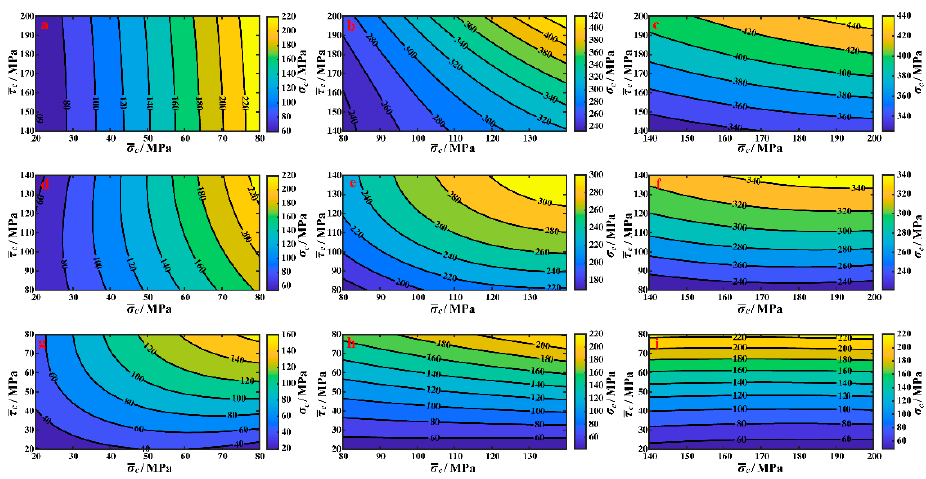
Figure 17. Response surface of peak strength.